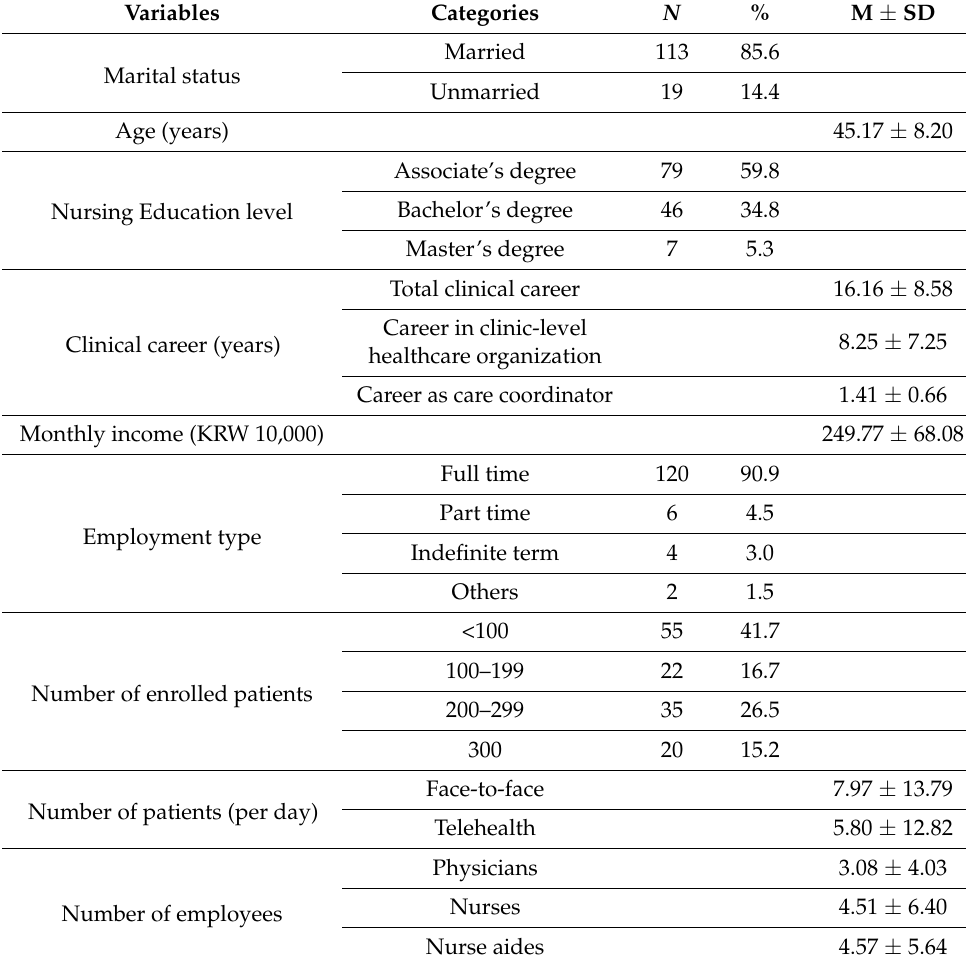
Table 1. General and Job-Related Characteristics of Participants ( N =